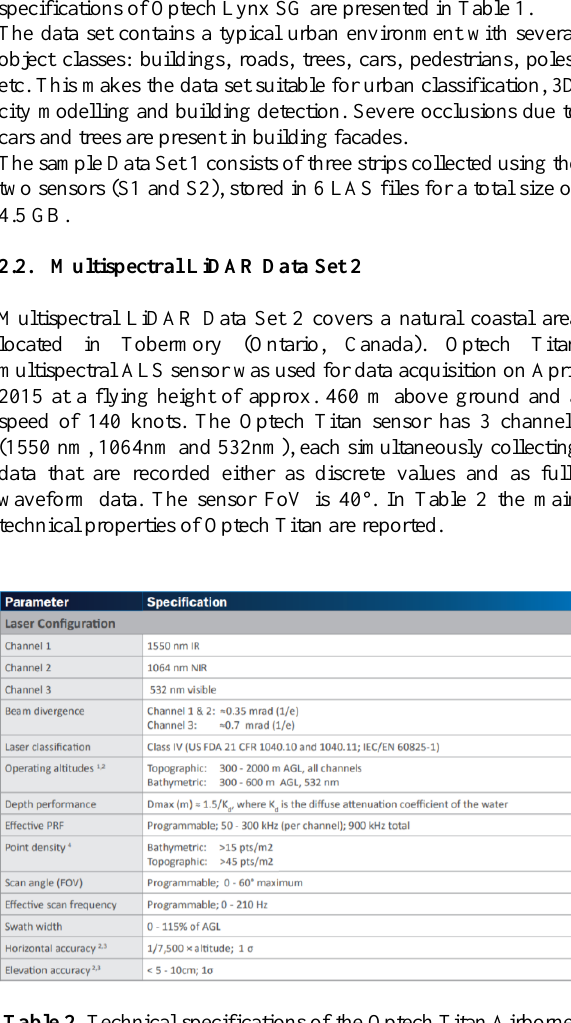
Table 2 . Technical specifications of the Optech Titan